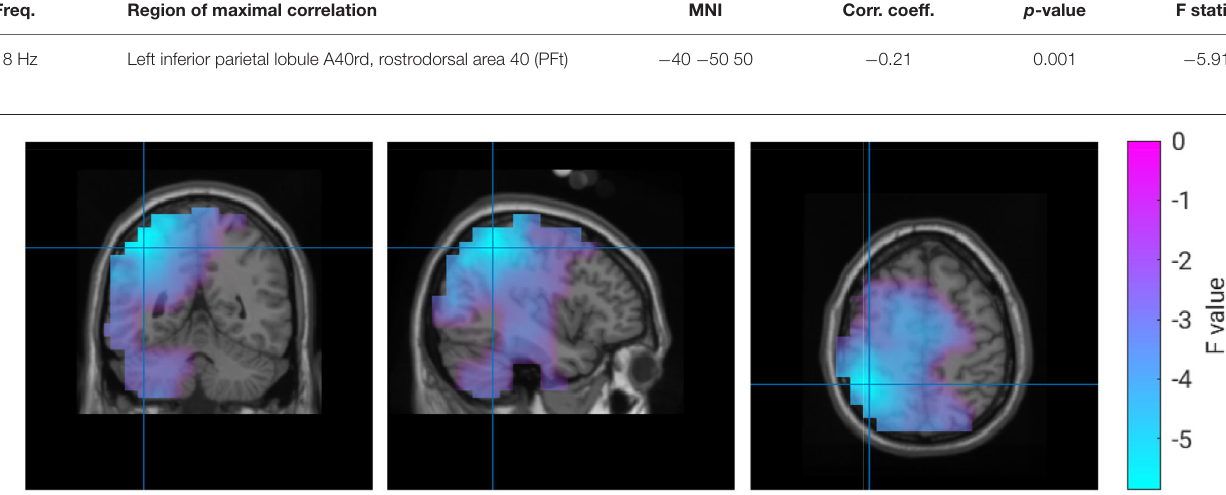
FIGURE 5 | Correlation between 18 Hz power and tracking error.